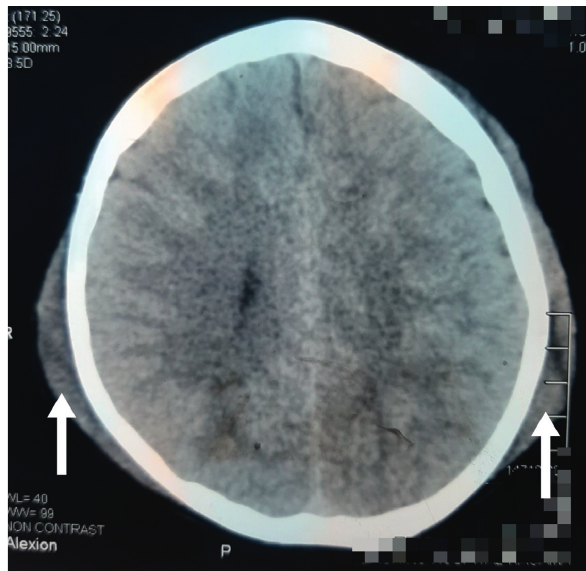
Figure 3: Noncontrast CT scan showing the soft tissue swelling of the scalp